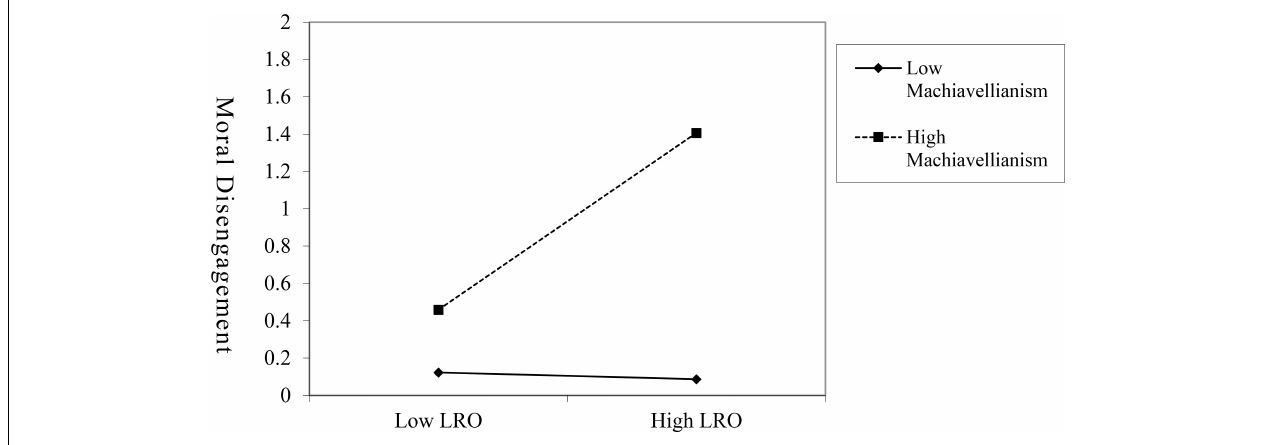
FIGURE 2 | Interaction of leader reward omission and machiavellianism predicting moral disengagement. N = 230, LRO = leader reward omission. TABLE 5 | Results of bootstrapping tests with 95% confidence intervals (CI): the moderated mediation roles of machiavellianism between leader reward omission and deviant behavior. Predicator Conditional indirect effect Moderated mediation